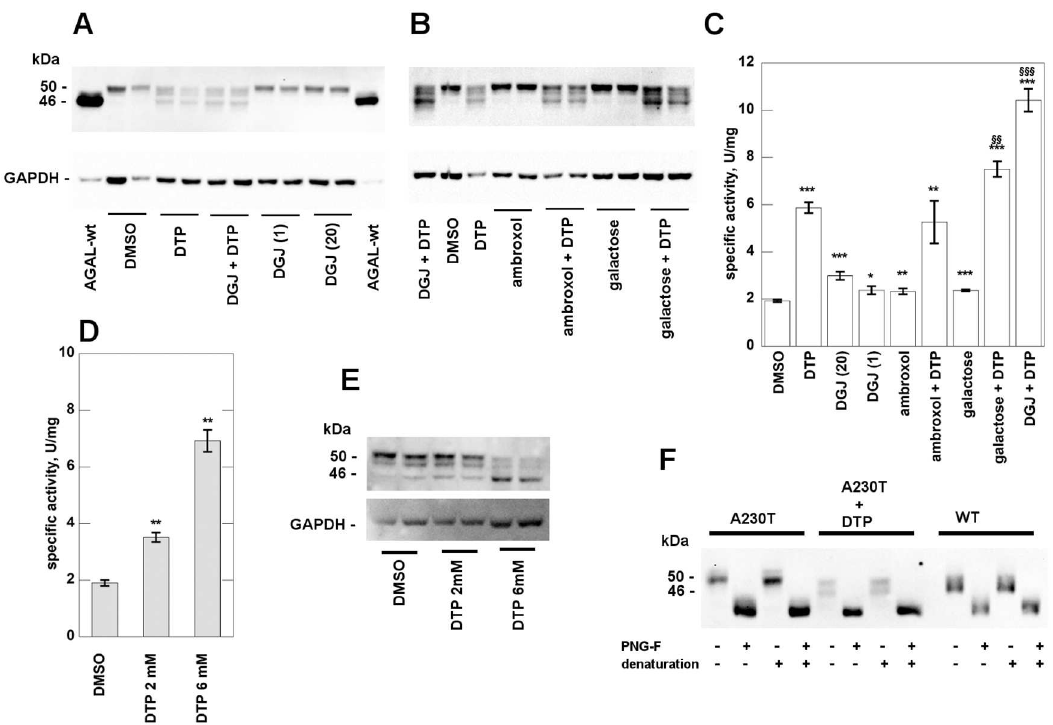
Fig 5. 2–6 dithiopurine rescues mutant human alpha-galactosidase in monotherapy or in synergy. COS-7 cells were cultured in conventional medium and transfected with plasmid containingA230T mutant. Cells were treated with: DTP 6 mM, DGJ 1 microM, DGJ 20 microM, ambroxol 40 microM, ambroxol 40 microM plus DTP 6 mM, galactose100 mM, galactose 100 mM plus DTP 6 mM, DGJ 1microM plus DTP 6 mM. All the moleculeswere dissolved in DMSO and an appropriate control was realized. After 48 h incubation, the cells were scraped and lysed then water-soluble extracts were analysedby western blotting (A and B) and enzyme assay (C). The effect of DTP 2 mM is shown in D and E. Cell extracts were treated with N-Glycosidase F and then analysedby WB (F). Standard deviations is indicatedby bars and differences that are statistically significant are flagged by * when compared to the control with DMSO (p < 0.05: * ; p < 0.01: **